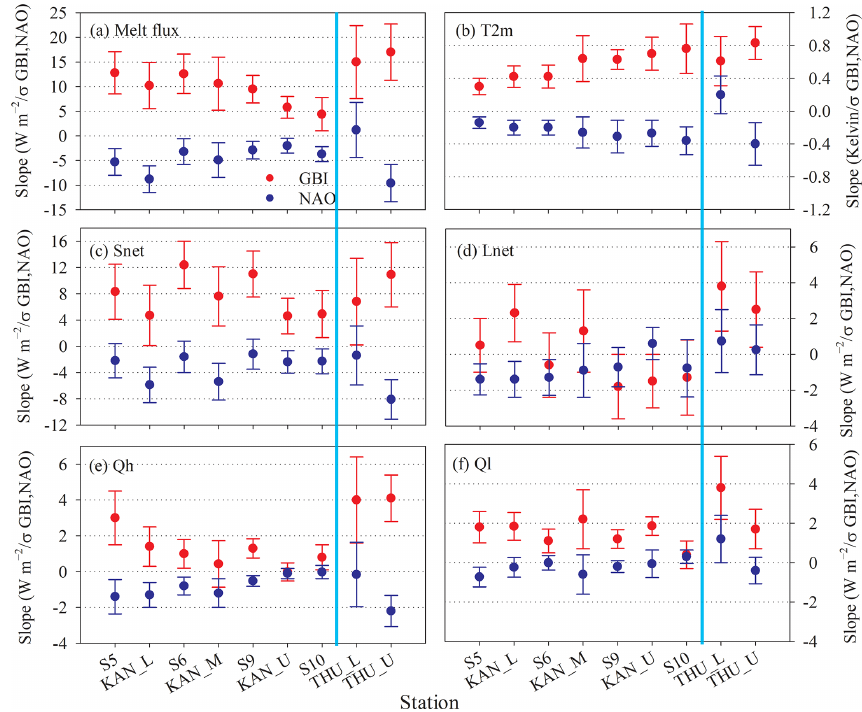
Figure 11. AWS regression slope of JJA average SEB components and 2m temperature ( T 2m ) with GBI (red dots) and NAO index (blue dots). The y axes are scaled with 1 standard deviation change in GBI and NAO circulation index to show (a) the melt flux change from SEB model (in Wm − 2 per σ GBI , NAO ), (b) 2m temperature change from station observations (in kelvin per σ GBI , NAO ), (c) S net change from station (in Wm − 2 per σ GBI , NAO ), (d) L net change from station (in Wm − 2 per σ GBI , NAO ), (e) Q h change from SEB model (in Wm − 2 per σ GBI , NAO ) and (f) Q l change from SEB model (in Wm − 2 per σ GBI , NAO ). Error bars indicate standard error in the multiyear JJA